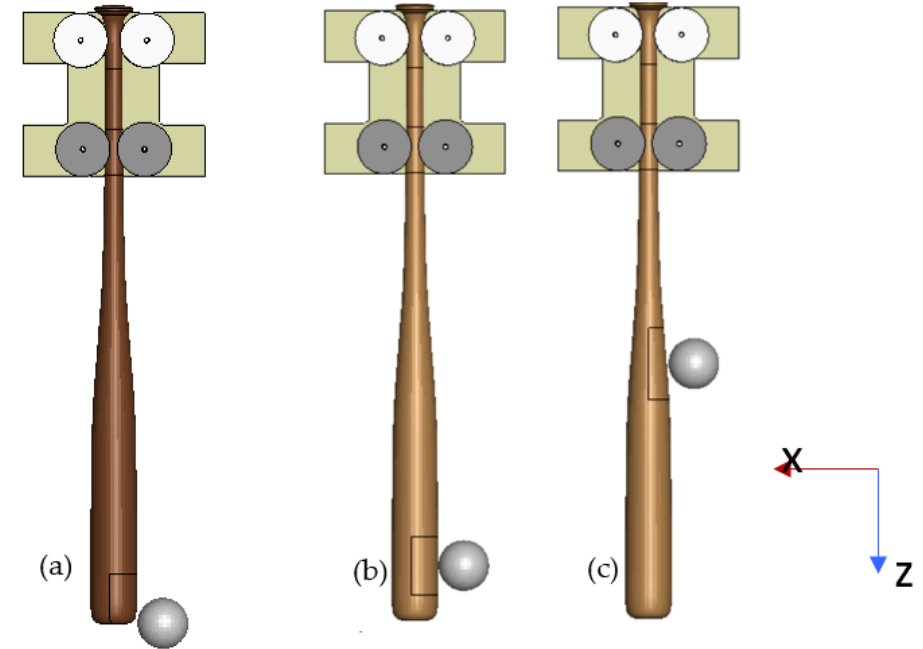
Figure 4. Ball impacts for the ( a ) 0.0 in (0 cm), ( b ) 2.0 in (5.1 cm), and ( c ) 14.0 in (35.6 cm) locations.